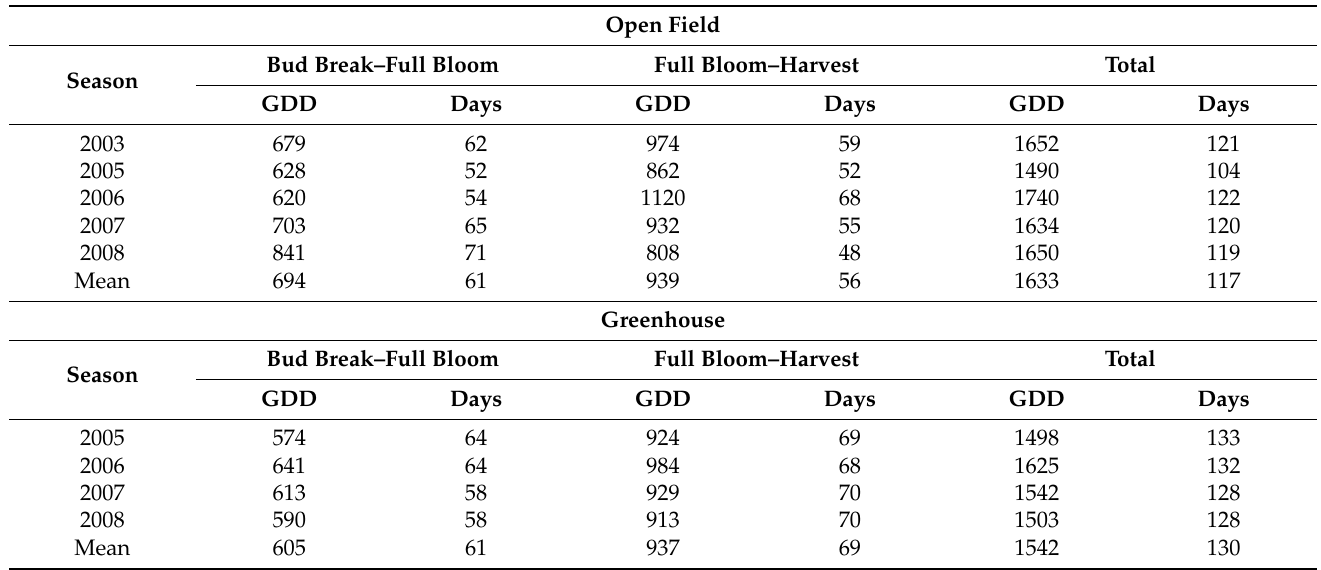
Table 2. Estimated heat requirements measured in growing degree days (GDD) with T b = 5 ◦ C and T u = 30 ◦ C, and season length duration in days of “Flame Seedless” grapevines cultivated in open field and in a plastic greenhouse.